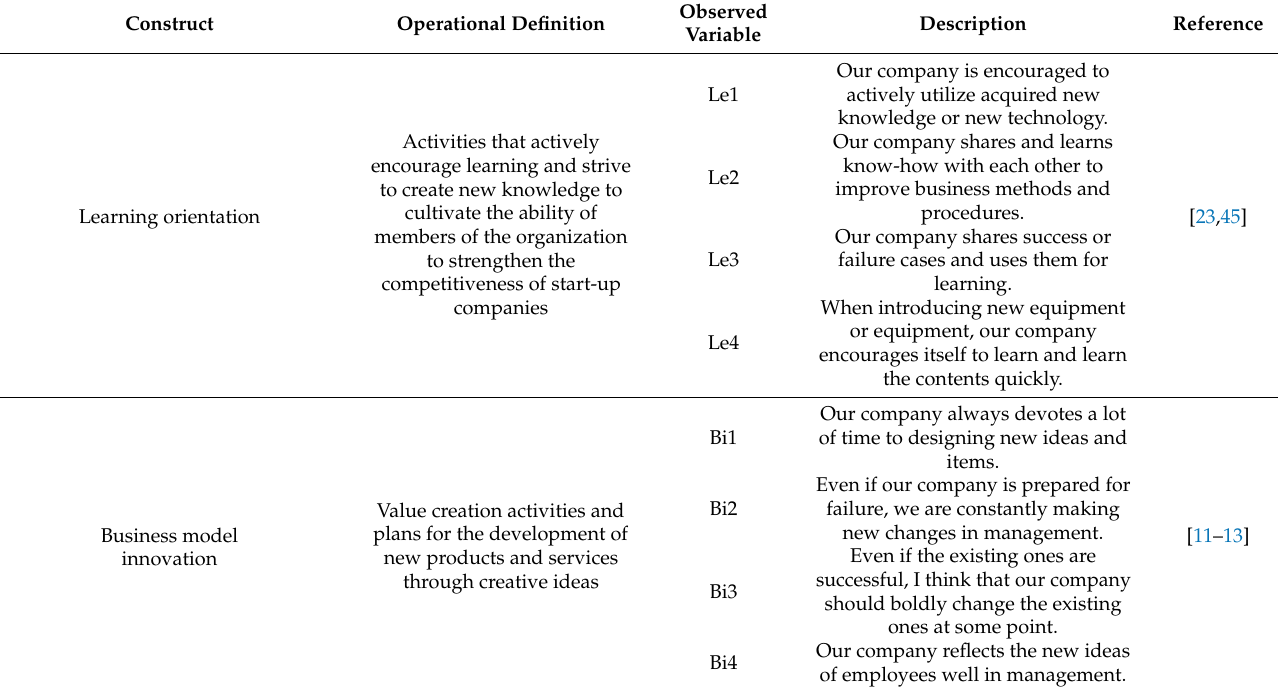
Table 1. Measurement variable and questionnaire